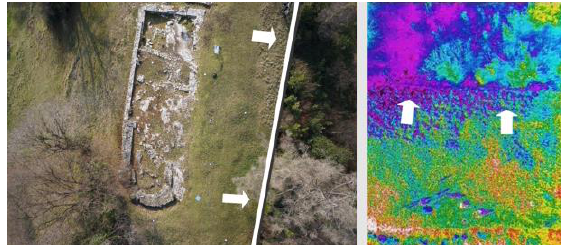
Fig. 12. Remains of a (supportive/defensive) wall for the site St. Pietro in